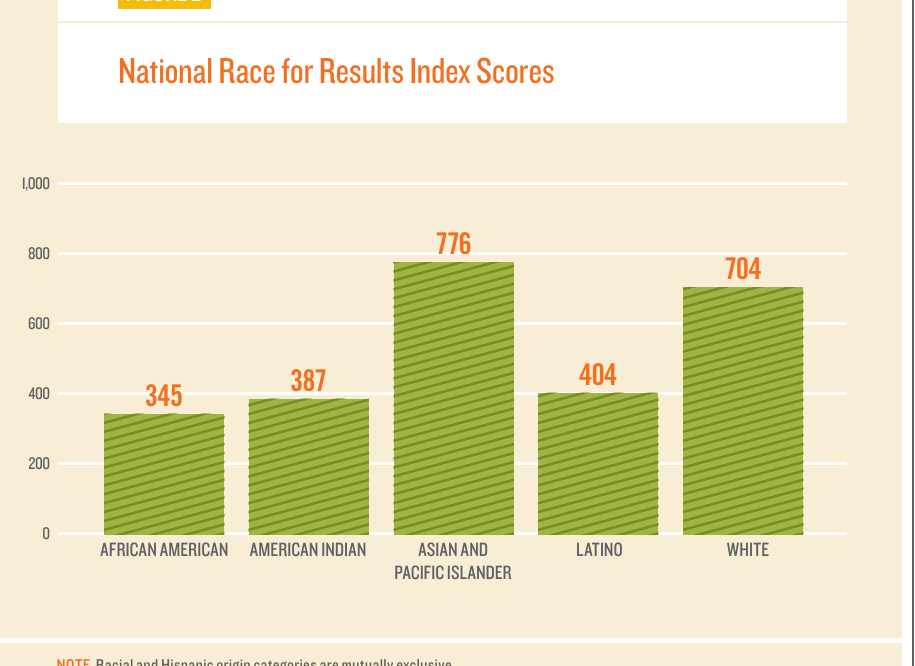
FIGURE 2 National Race for Results Index